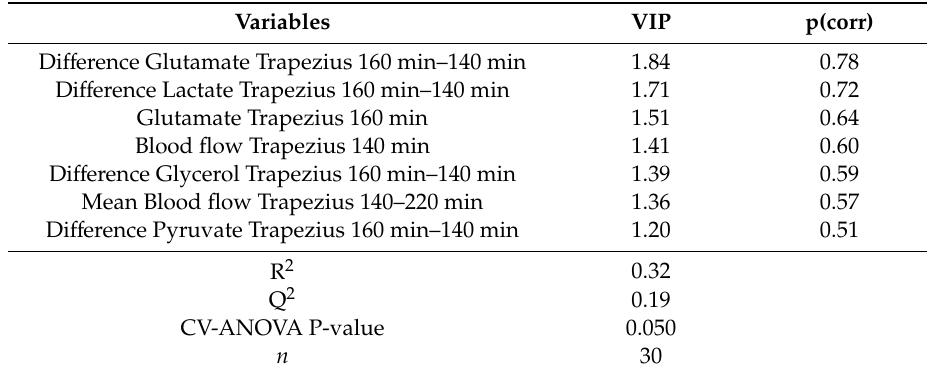
Table 7. OPLS of PPT over trapezius in FM. Regressors used data from microdialysis of this muscle (except pain variables from microdialysis) (cf. Table 3). Only significant variables are shown (i.e., the variables with VIP > 1.0 and absolute p(corr) ≥ 0.50).